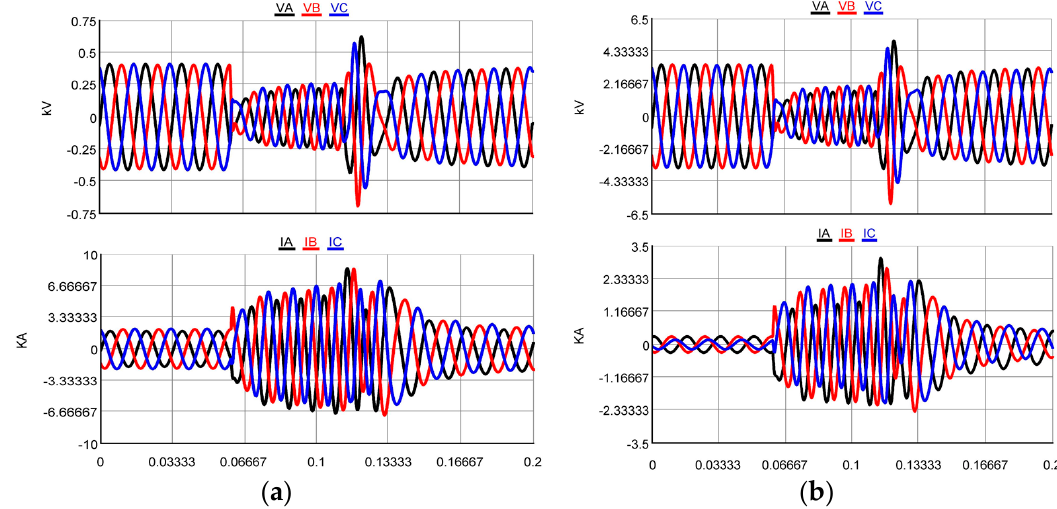
Figure 8. Three-phase fault applied at bus 6 in the transmission system of the testbed: ( a ) instantaneous voltage and current at bus 634; ( b ) instantaneous voltage and current at bus 680.